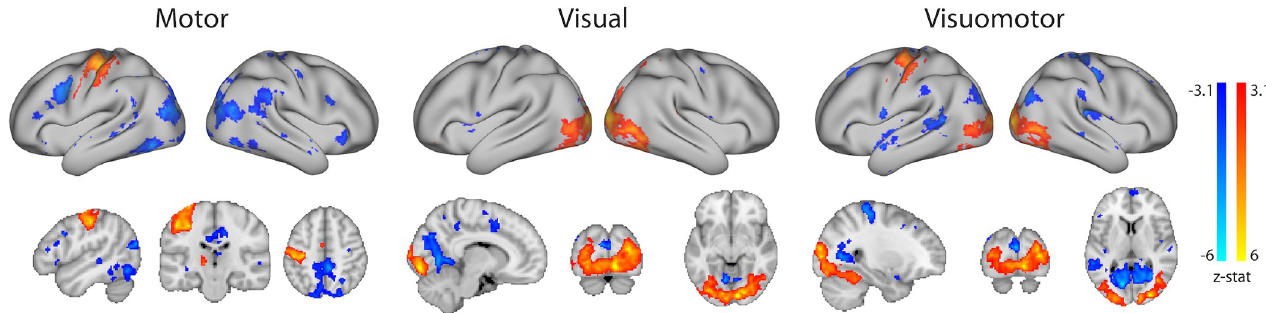
Fig 2. Group activation maps corresponding to each of the steady-states employed in the task localizer scan. All activation foci are projected onto the inflated surface of a template brain as well as on three anatomical planes.